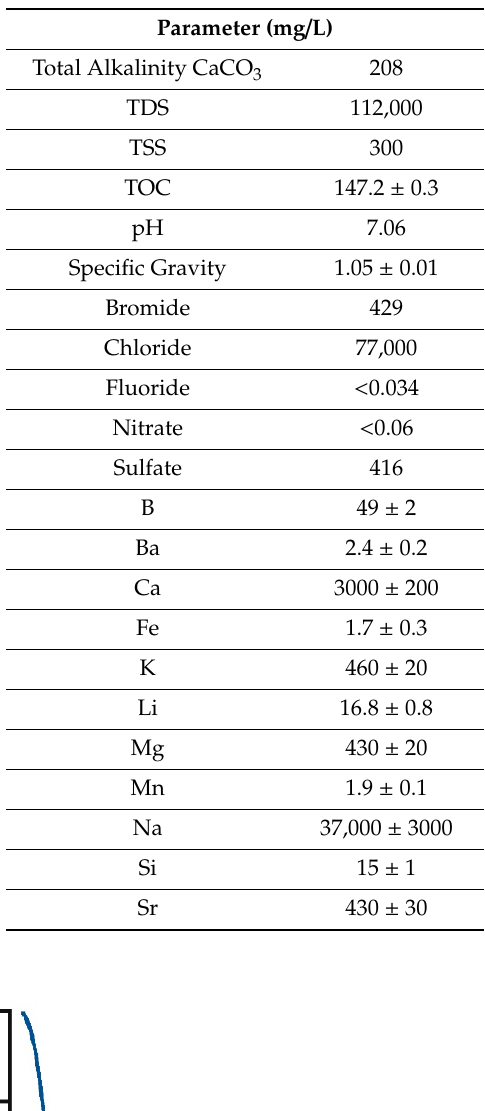
Table 3. Analytical parameters measured for the raw PW.